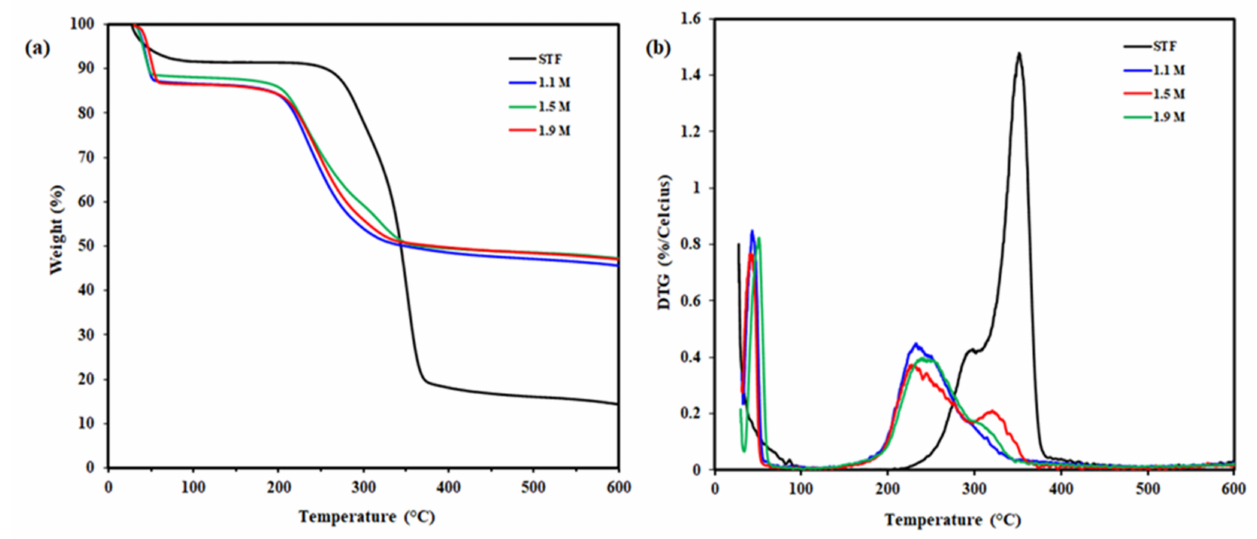
Figure 10. TGA ( a ) and DTG ( b ) thermograms of STFs and CNCs under different APS concentrations at 70 ◦ C for 16 h.